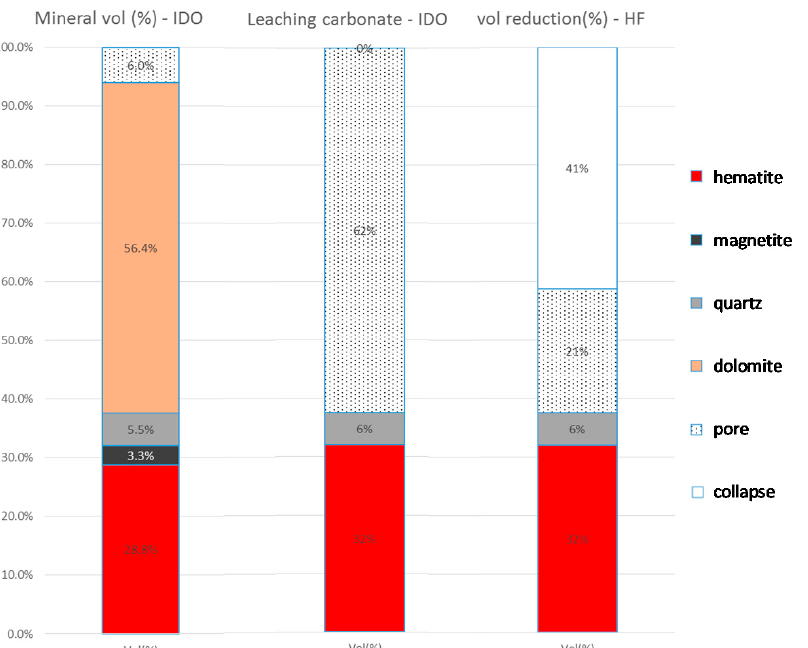
Figure 10. Original mineralogy and porosity in a volume of dolomite itabirite (IDO), leaching volume and friable product hematitite (HF) with 36% of porosity and 41% of original volume collapsed.